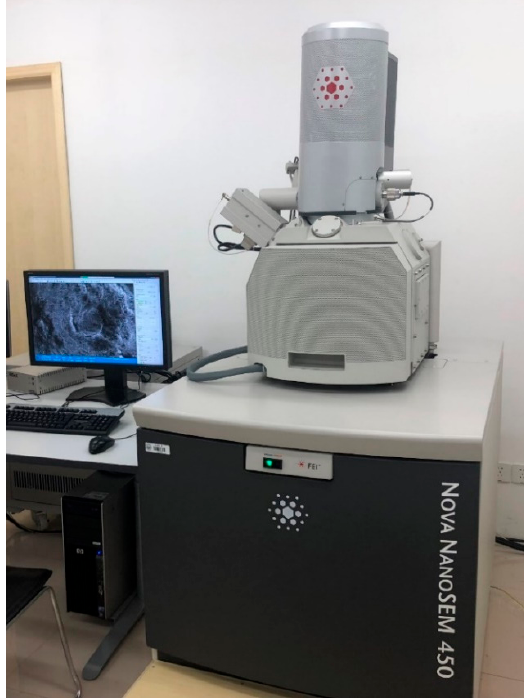
Figure 4. SEM system-Nova NanoSEM 450.